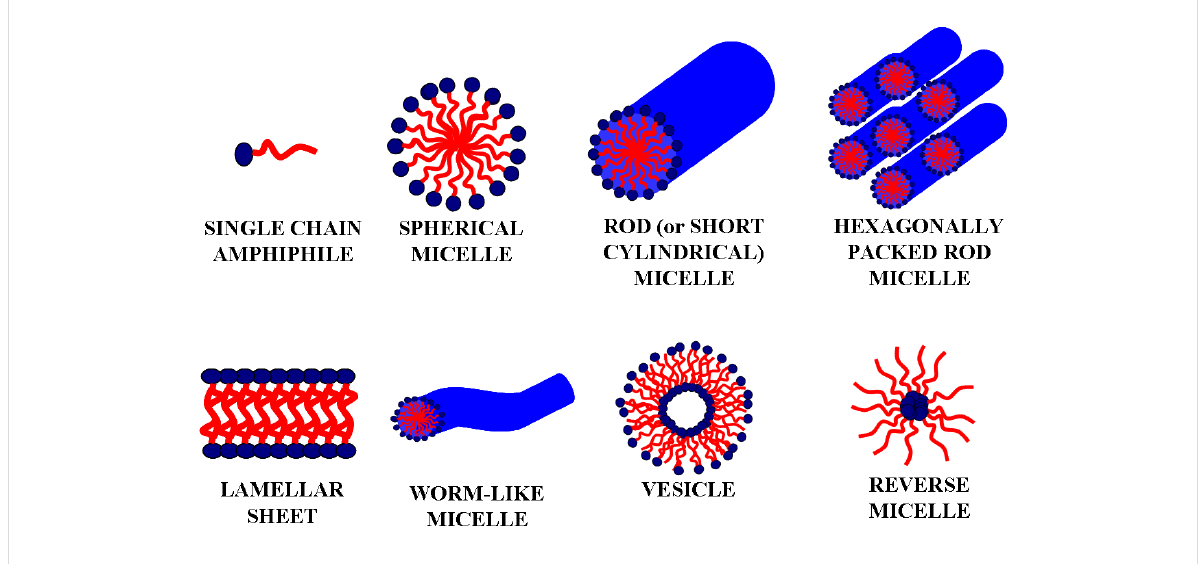
Figure 5: Schematic representation of different micellar architectures. Hydrophilic polar heads are indicated in blue, and hydrophobic non-polar tails are drawn in red. Reprinted from [22] (“Selective porous gates made from colloidal silica nanoparticles”); source published under Creative Commons Attribution 2.0 license, https://creativecommons.org/licenses/by/2.0/; copyright the authors.